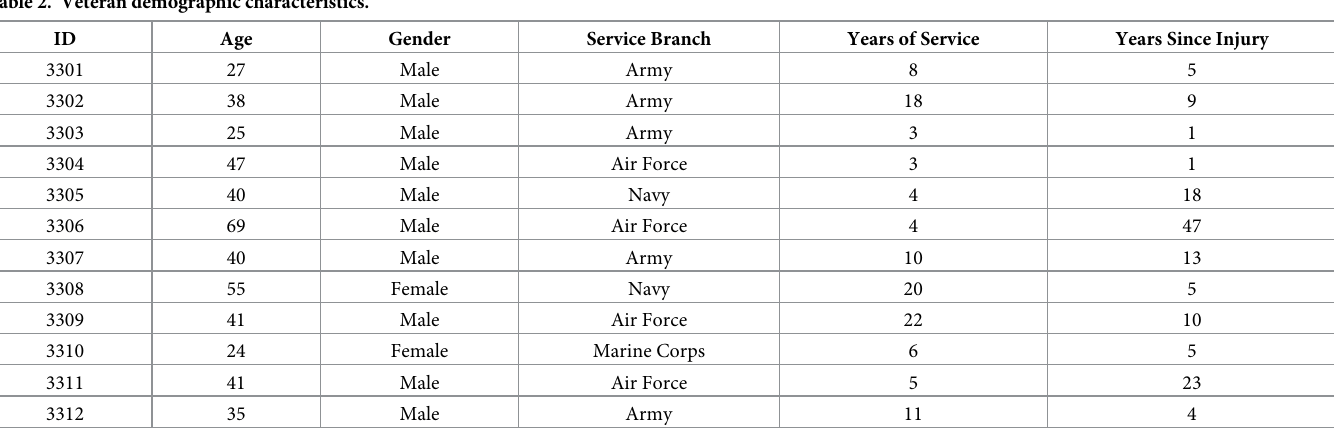
Table 2. Veteran demographic characteristics.